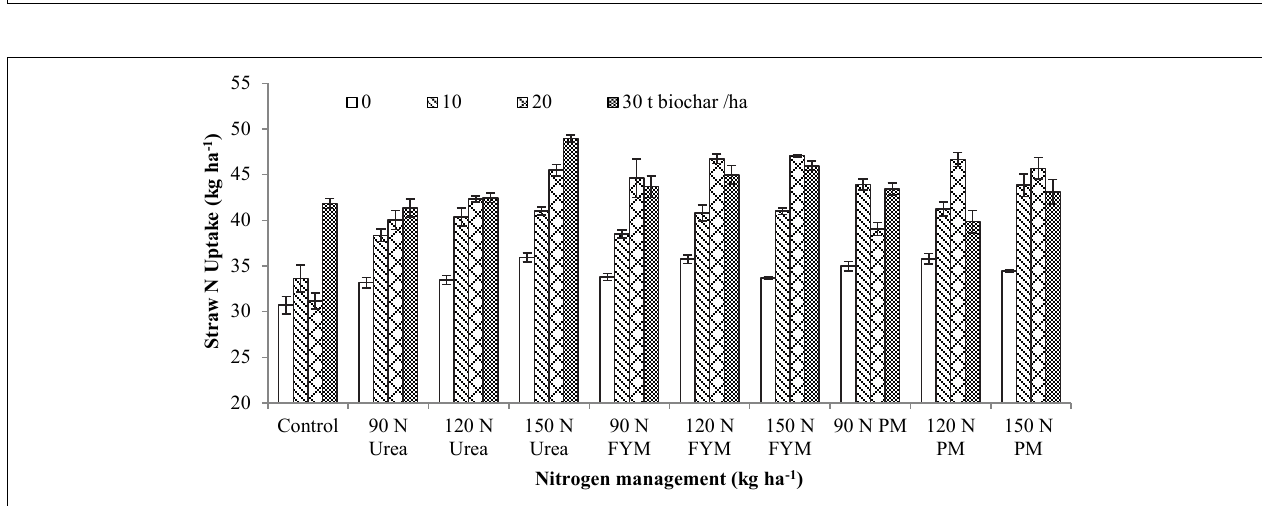
FIGURE 8 | Interactive effect biochar and N levels applied from different sources on grain nitrogen uptake of wheat. Bars on graph denote SE of mean ( n = 3). FYM, farmyard manure; PM, poultry manure.